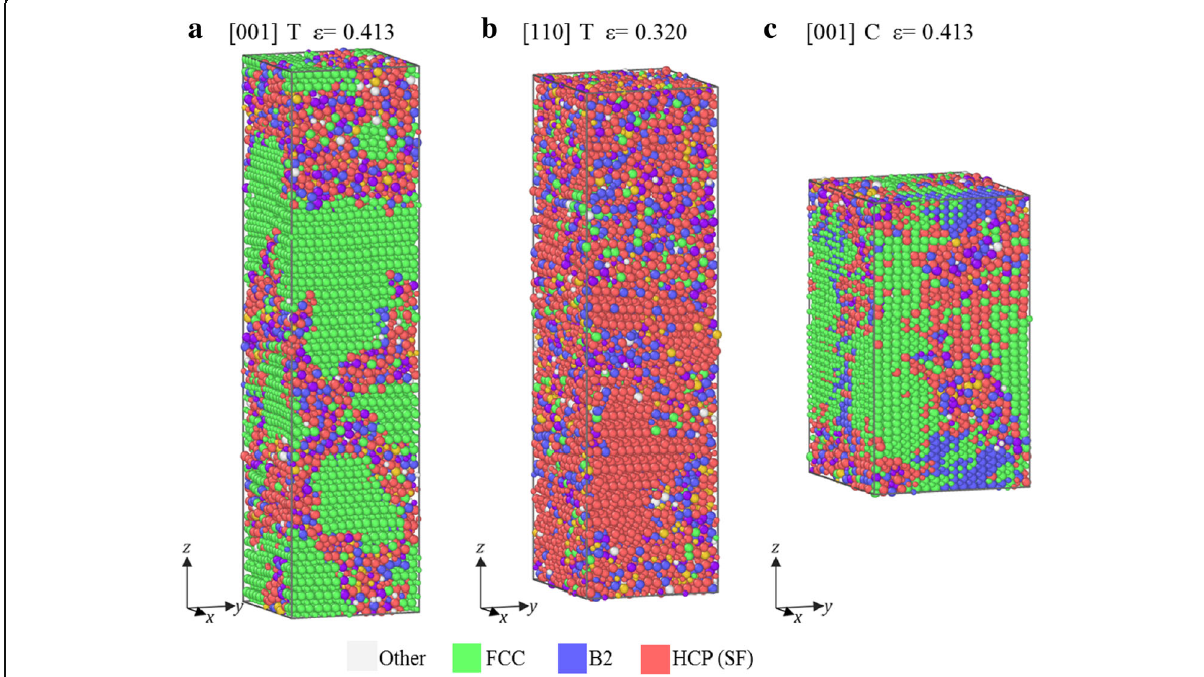
Fig. 4 Atomic configurations in samples at failure strain. a Under tension along [001], b under tension along [110], and c under compression along [111]